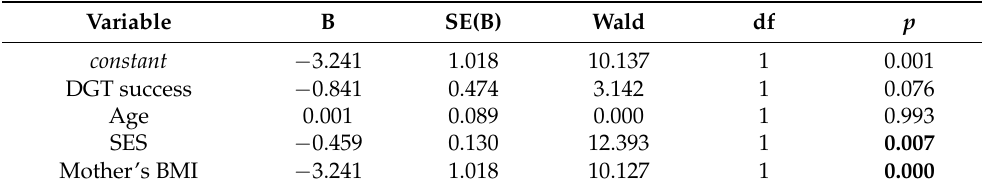
Table 2. The results of logistic regression for excess body mass according to DGT results and cofounding